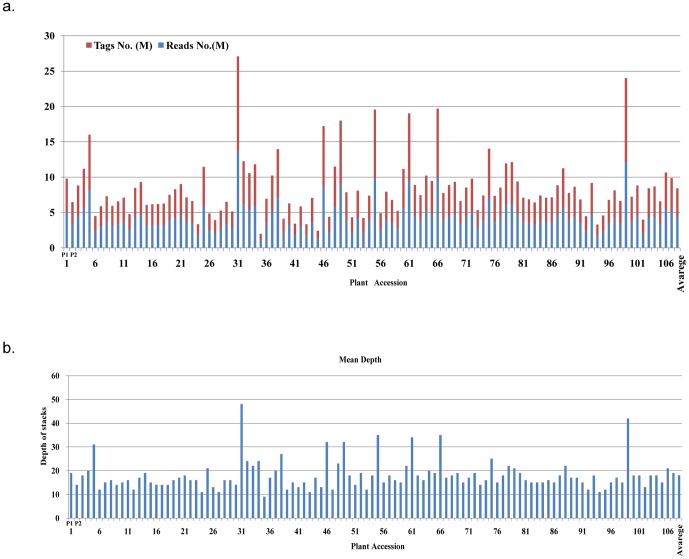
The statistics of reads, tags and stacks in 107 F1 plant accessions.(a) The number of tags and reads of the F1 population; (b) The mean depth of stacks in each individual.The ID 1 and 2 are the P1 (Female parent) and P2 (Male parent) respectively.